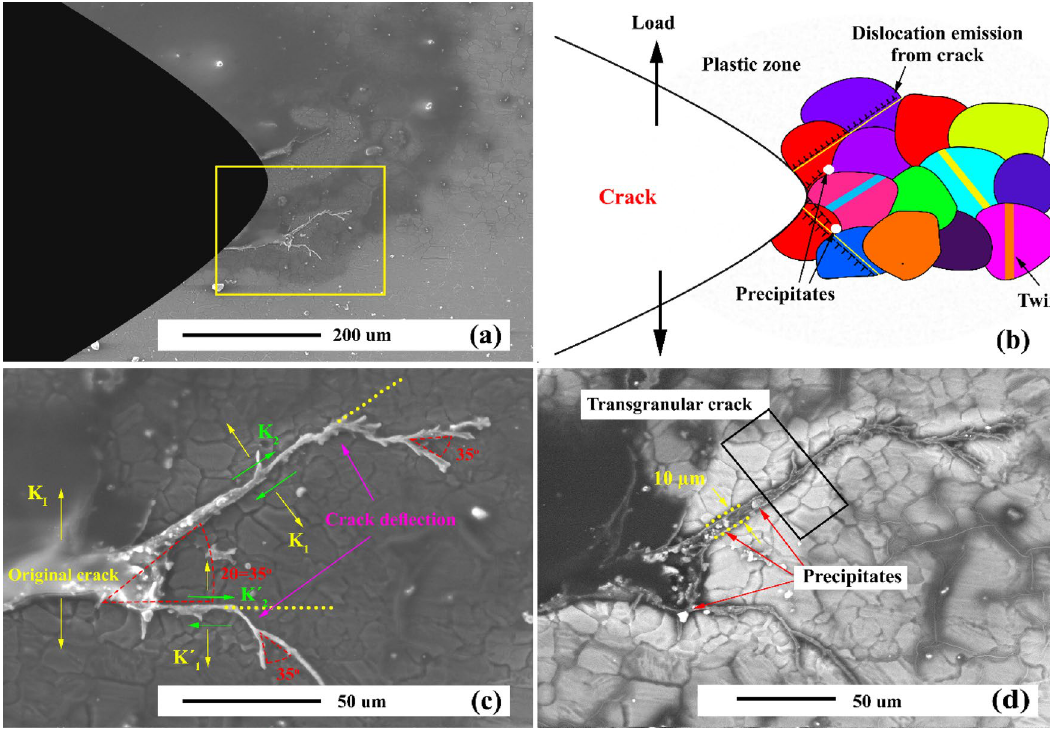
Figure 19. ( a ) SEM micrograph of aged unreinforced alloy after thermal cycles at 350 °C, and ( b ) schematics of crack propagation through the grains, ( c ) higher magnification of micrograph ( a ) in SE mode, and ( b ) higher magnification of micrograph ( a ) in BSE